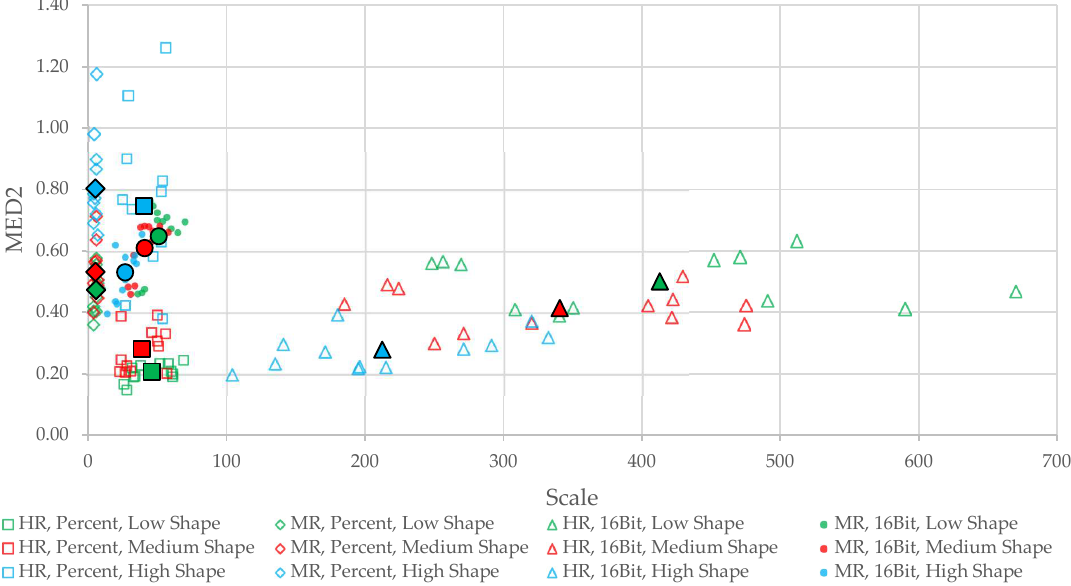
Figure 4. Scale parameter vs. MED2 graph showing the results for each spatial resolution (HR and MR), reflectance storage scale (16Bit and Percent), and shape parameter category (Low Shape, Medium Shape, and High Shape). Note: average values of each reflectance storage scale and shape category are depicted in a solid and larger symbol.